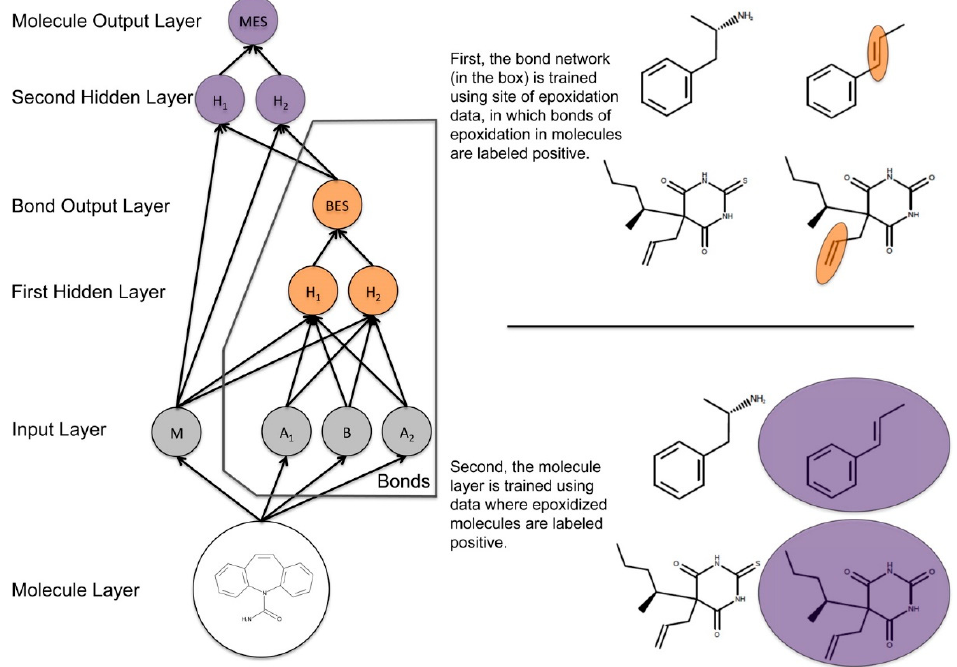
Figure 5. This diagram represents a simplification of the structure of the epoxidation model, which was made up of one input layer, two hidden layers, and two output layers. The actual model had several additional nodes in the input and hidden layers. In the input layer, M represents the molecule input node, B is the bond input node, and two atom input nodes (for each atom associated with the bond). The bond epoxidation score (BES) quantifies the probability that the bond is a site of epoxidation based in the input from the nodes of the first hidden layer (H 1 and H 2 ). The molecule epoxidation score (MES) reflects the probability that the molecule will be epoxidized. This score is calculated with the information from the all molecule-level descriptors and the BES. The bond network and the molecule network are represented in orange and purple respectively [57].